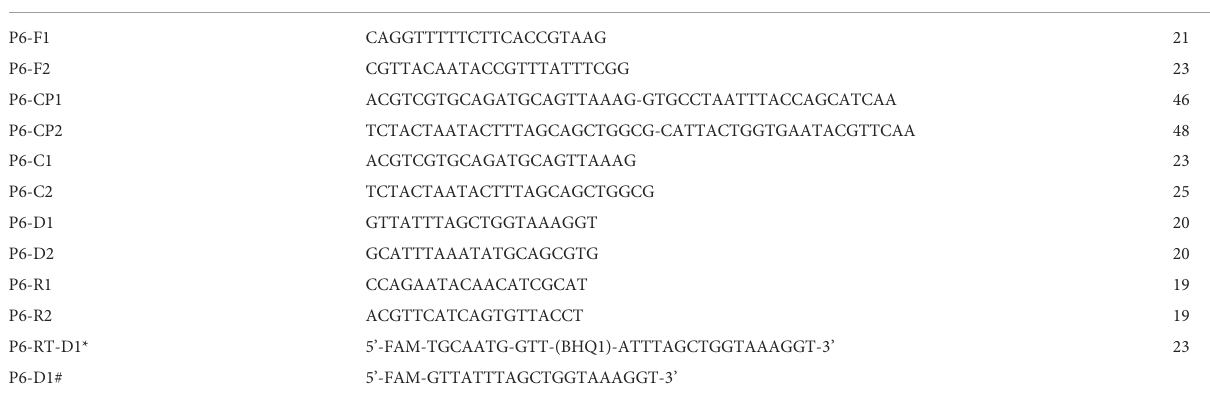
TABLE 1 The primers used in the study.